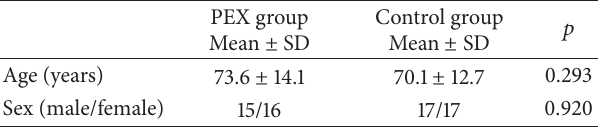
Table 1: Demographics of pseudoexfoliation and control groups.